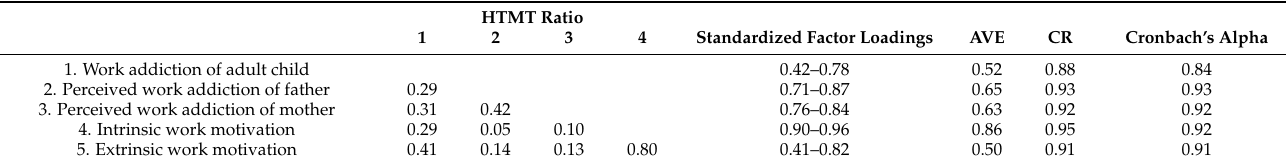
Table 2. Reliability and validity of the instruments.